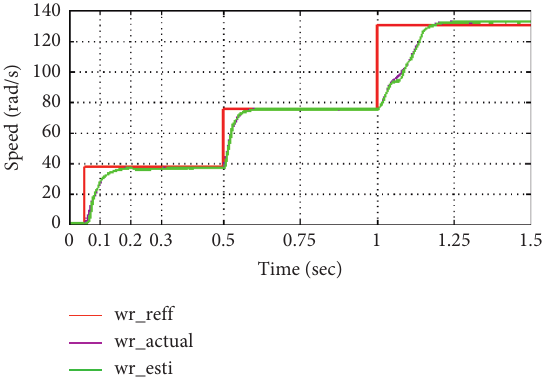
Figure 17: 50% decrease of R r from its nominal value for different rotor speeds.